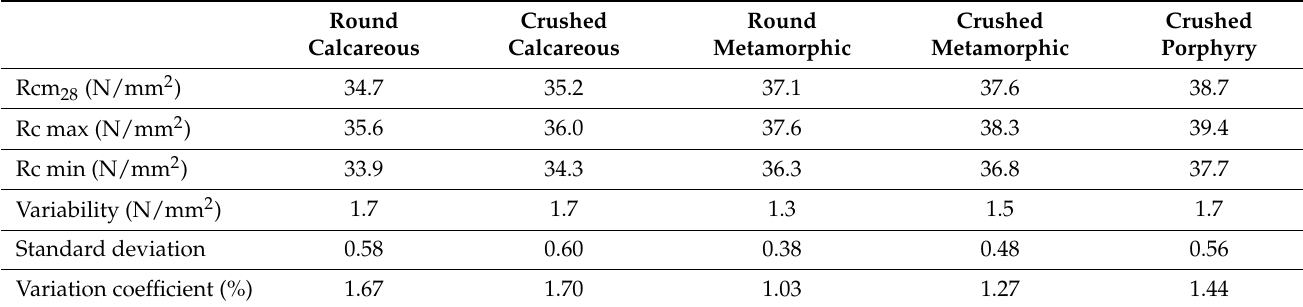
Table 17. Comparison of the compressive strength value (Rcm 28 ) of the five different mixtures analyzed, with the maximum and minimum values, variability, standard deviation (all these values expressed in N/mm 2 ) and the variation coefficient expressed in